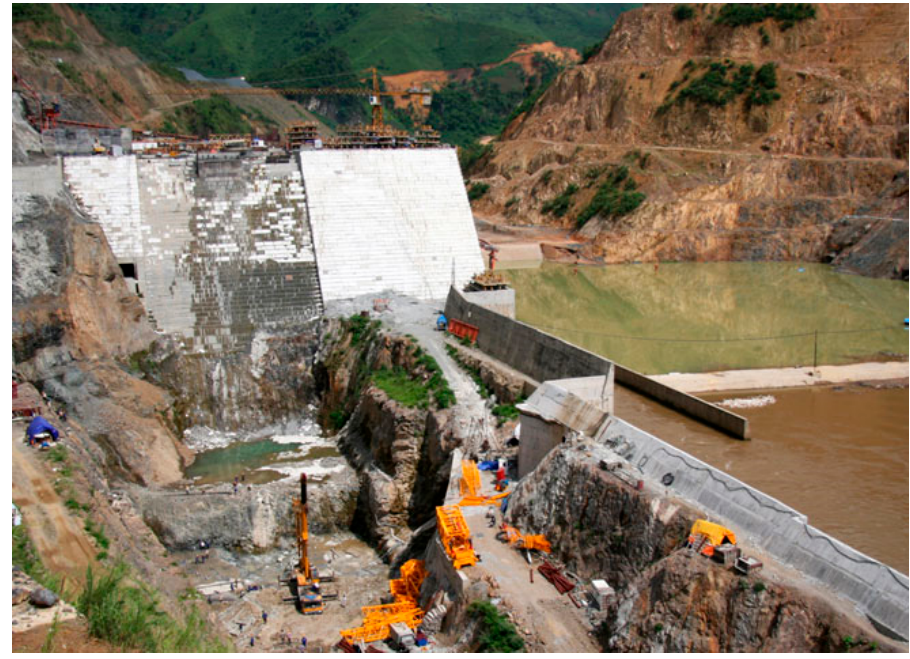
Figure 1. Ban Chat hydroelectric plant in Vietnam [6].